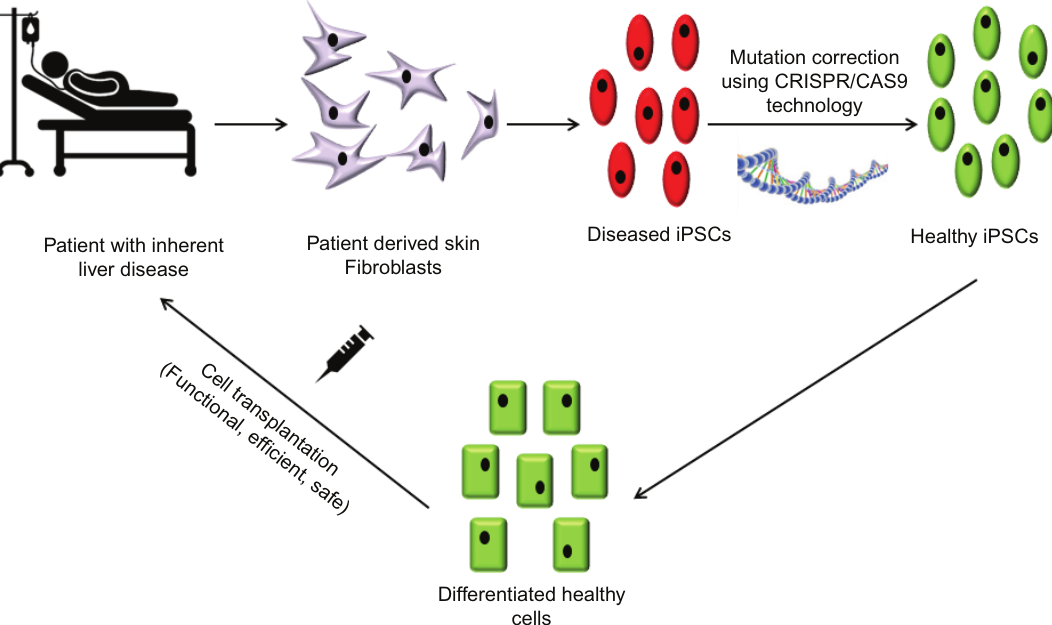
Figure 3. Clinical application of clustered regularly interspersed short palindromic repeats (CRISPR/Cas9). Skin fi broblasts from patient source can be dedifferentiated to pluripotent stem cells containing the disease causing mutation. This mutation can be corrected by CRISPR/Cas9 technology resulting in healthy stem cells which can be redifferentiated to patient-speci fi c healthy cells for